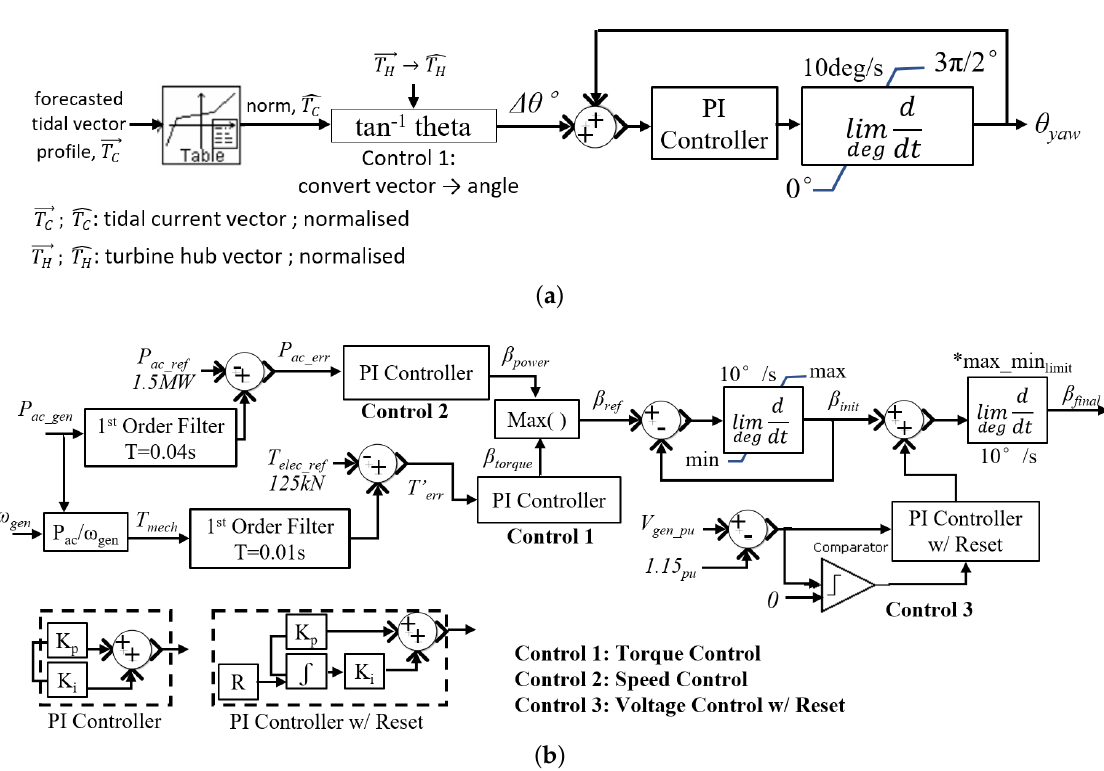
Figure 5. ( a ) TST yaw controller; ( b ) TST torque-controlled blade pitch